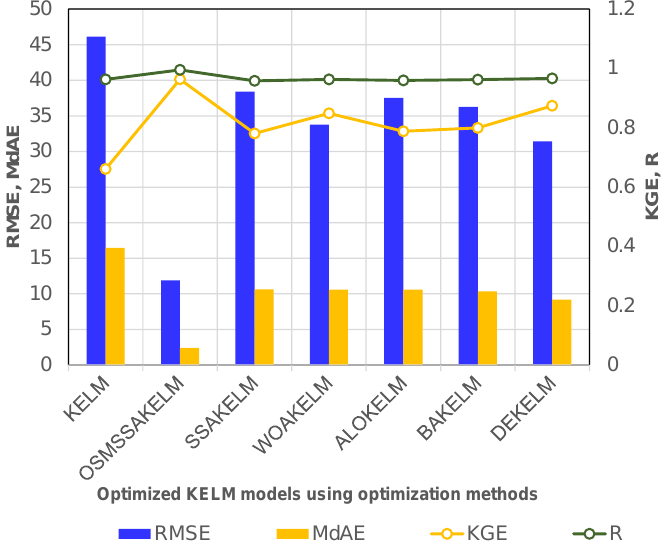
Figure 14. Comparison of optimized KELM models for the testing phase based on the RMSE, MdAE, KGE, and R